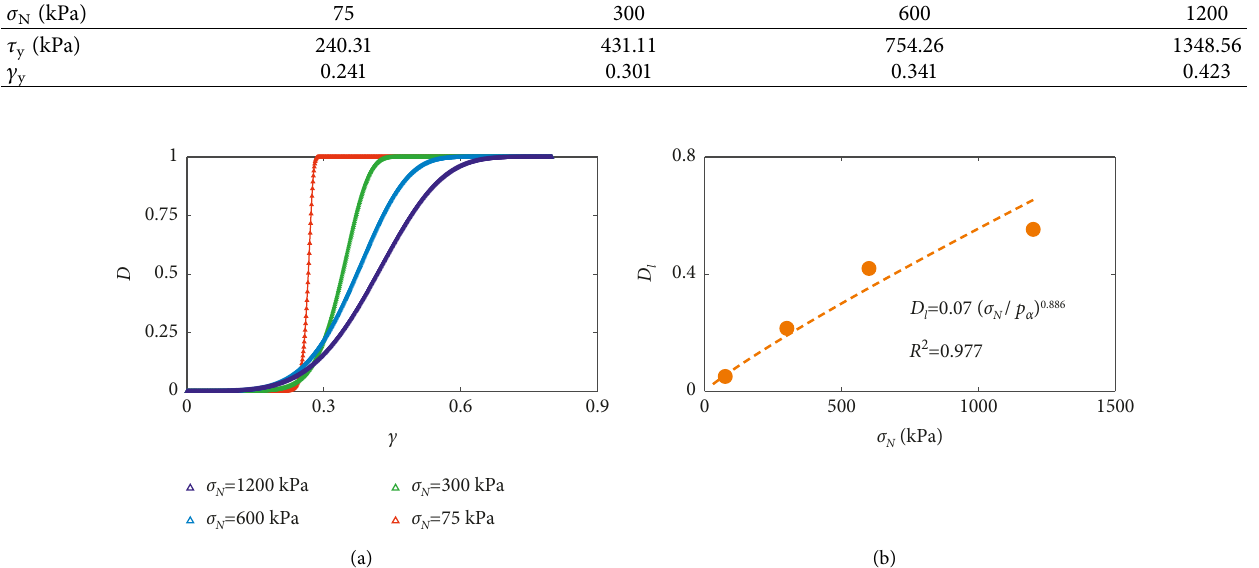
Figure 7: Variations of (a) D versus c and (b) D l versus σ N . D l is the critical damage. p a was introduced to make the expression independent of the choice of the units, and its value is 101 kPa